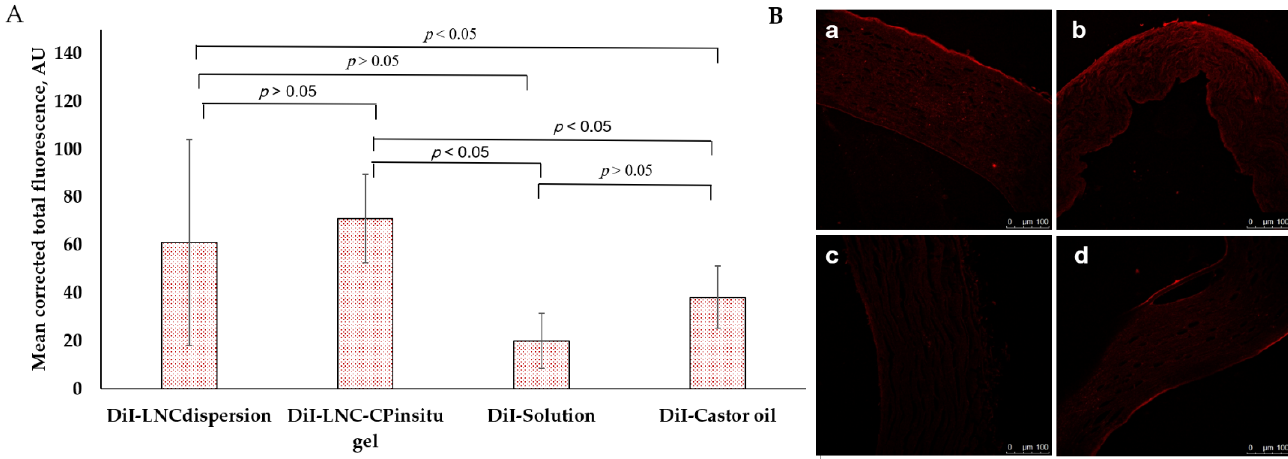
Figure 5. In vivo corneal biodistriution 3 h post administration showing: ( A ) Mean corrected total fluorescence of corneas following administration of different DiI formulations and ( B ) confocal images of cornea layers following administration of ( a ) DiI-LNC dispersion , ( b ) DiI-LNC-CP in situ gel , ( c ) control DiI-Solution, and ( d ) DiI-Castor oil, scale bar 100 µm.